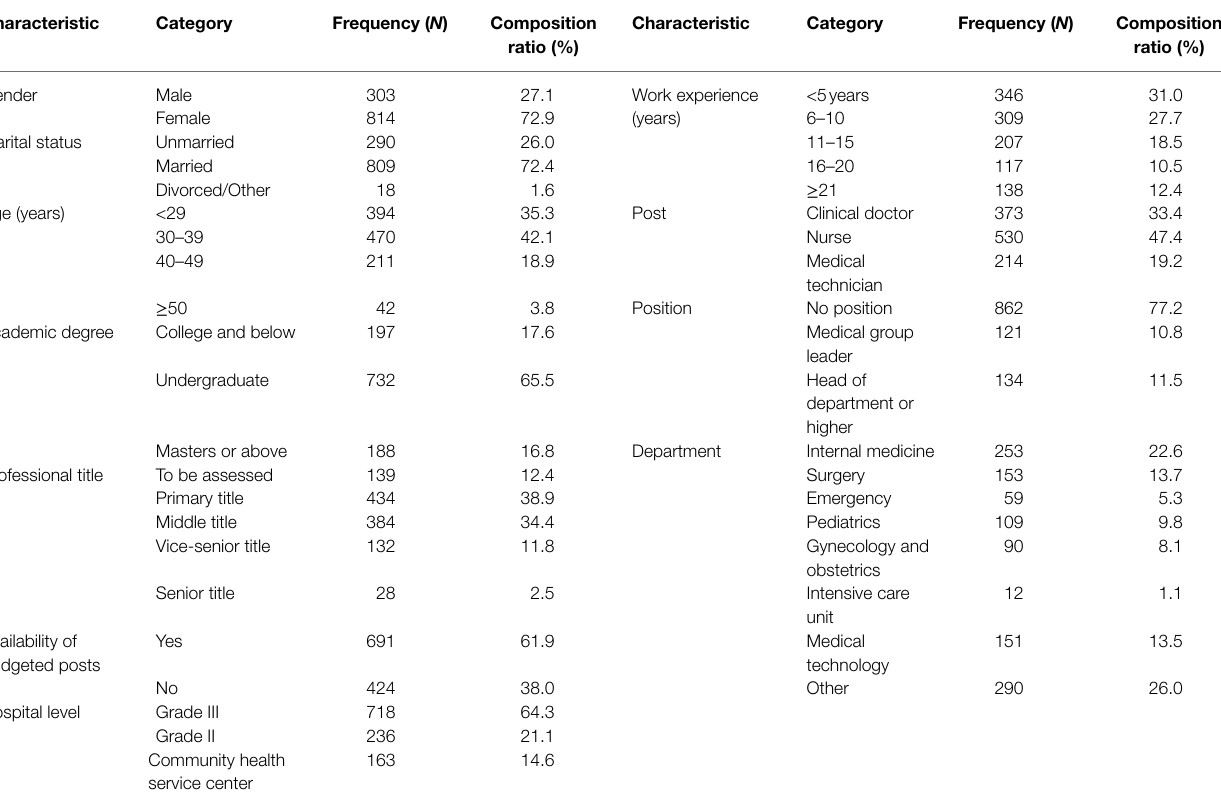
TABLE 1 | Descriptive statistics of the sample ( N = 1,117).